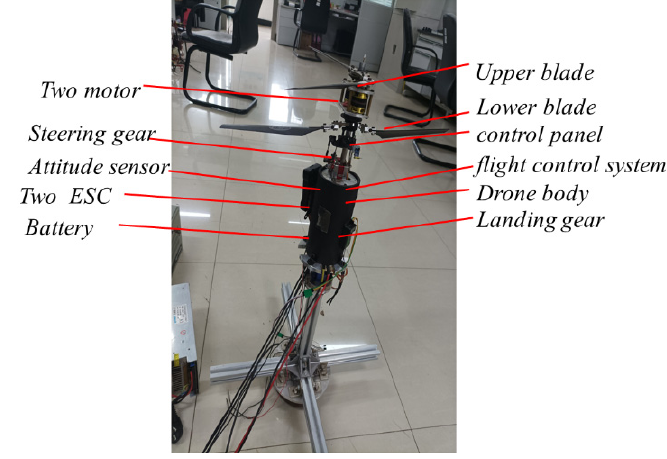
Figure 4. Structure diagram of the prototype of a coaxial twin-rotor.